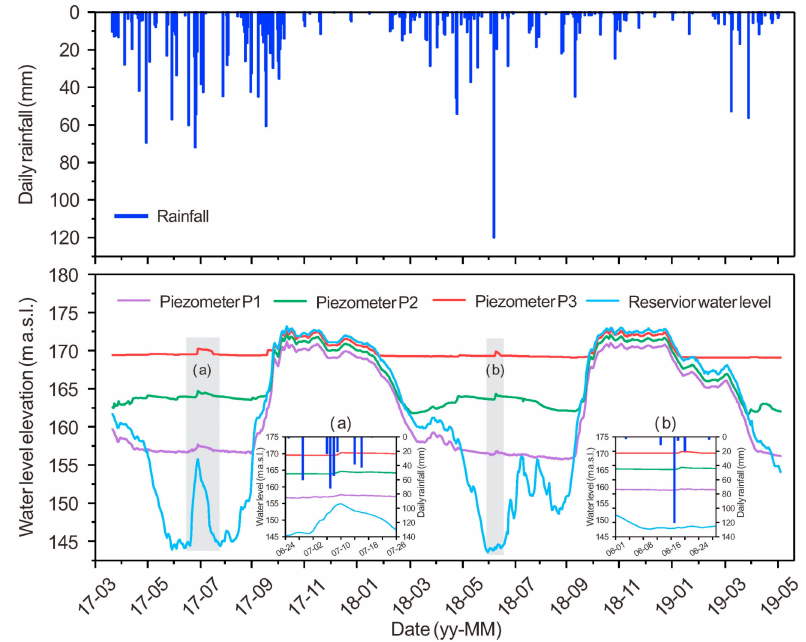
Figure 14. Comparative diagram of the daily rainfall, reservoir level, and groundwater levels measured by piezometers: (a–b) detail drawings in July 2017 and June